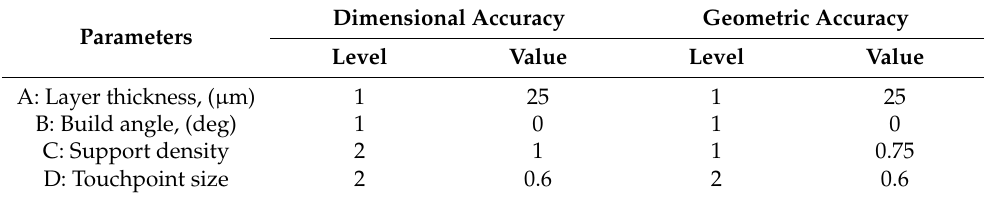
Table 22. Optimum values of parameters for dimensional accuracy and geometric characteristic of cast